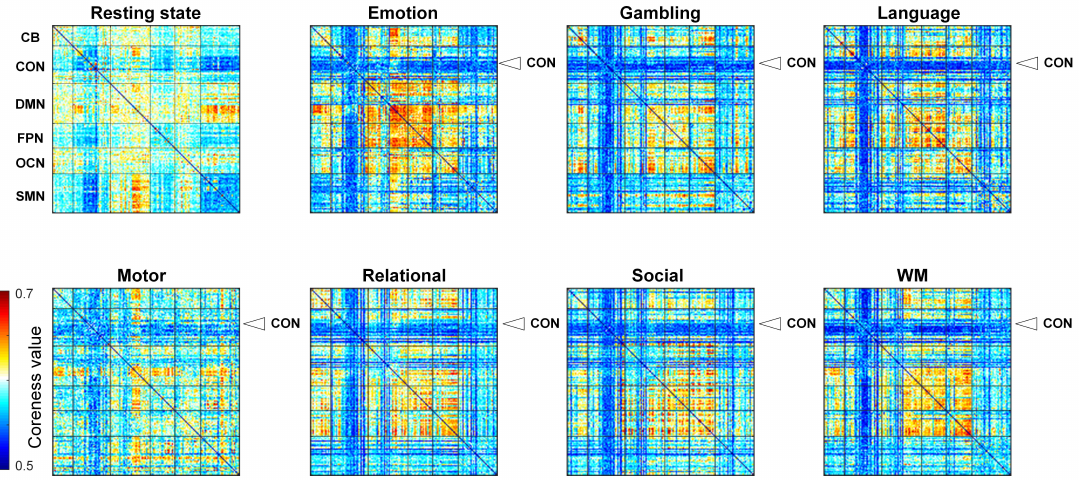
Figure 3. The resting-state and task core-quality value matrix. The coreness vectors of all the connectivity pairs are rearranged into the ROI-ROI index